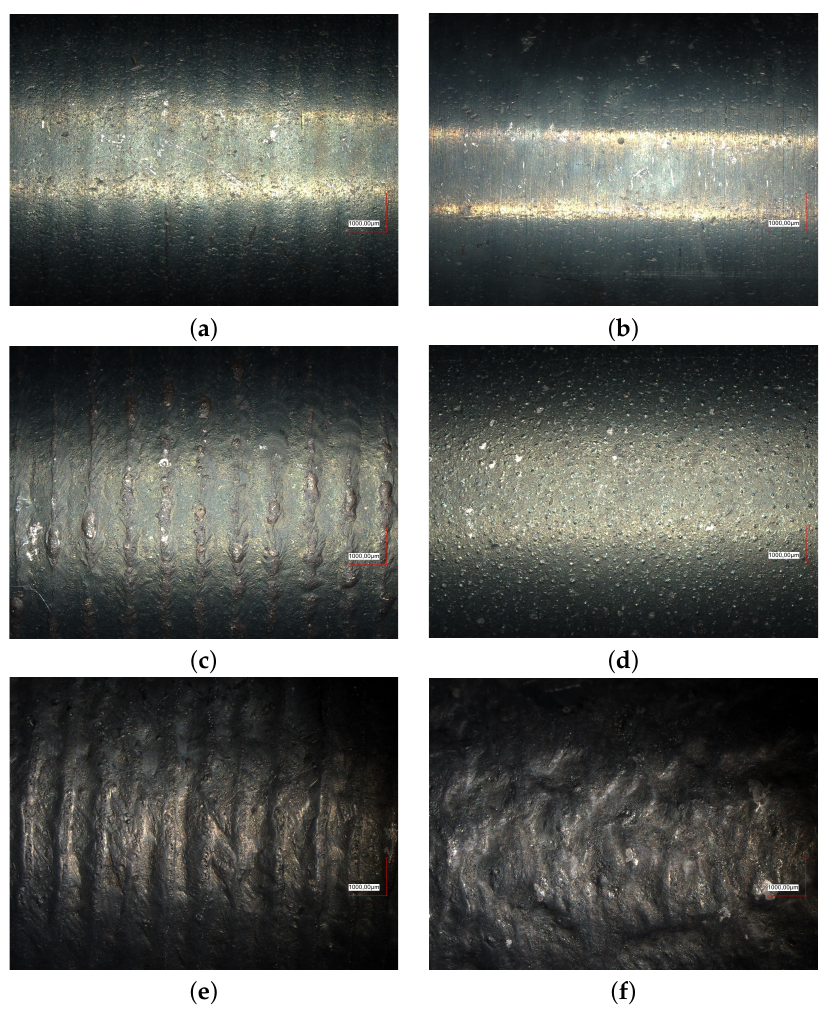
Figure 9. Surface condition of the sample after heat treatment experiment: ( a ) I = 40 A, ω p = 1 rot/s, ( b ) I = 40 A, ω p = 2 rot/s, ( c ) I = 60 A, ω p = 1 rot/s, ( d ) I = 60 A, ω p = 2 rot/s, ( e ) I = 80 A, ω p = 1 rot/s, ( f ) I = 80 A, ω p = 2